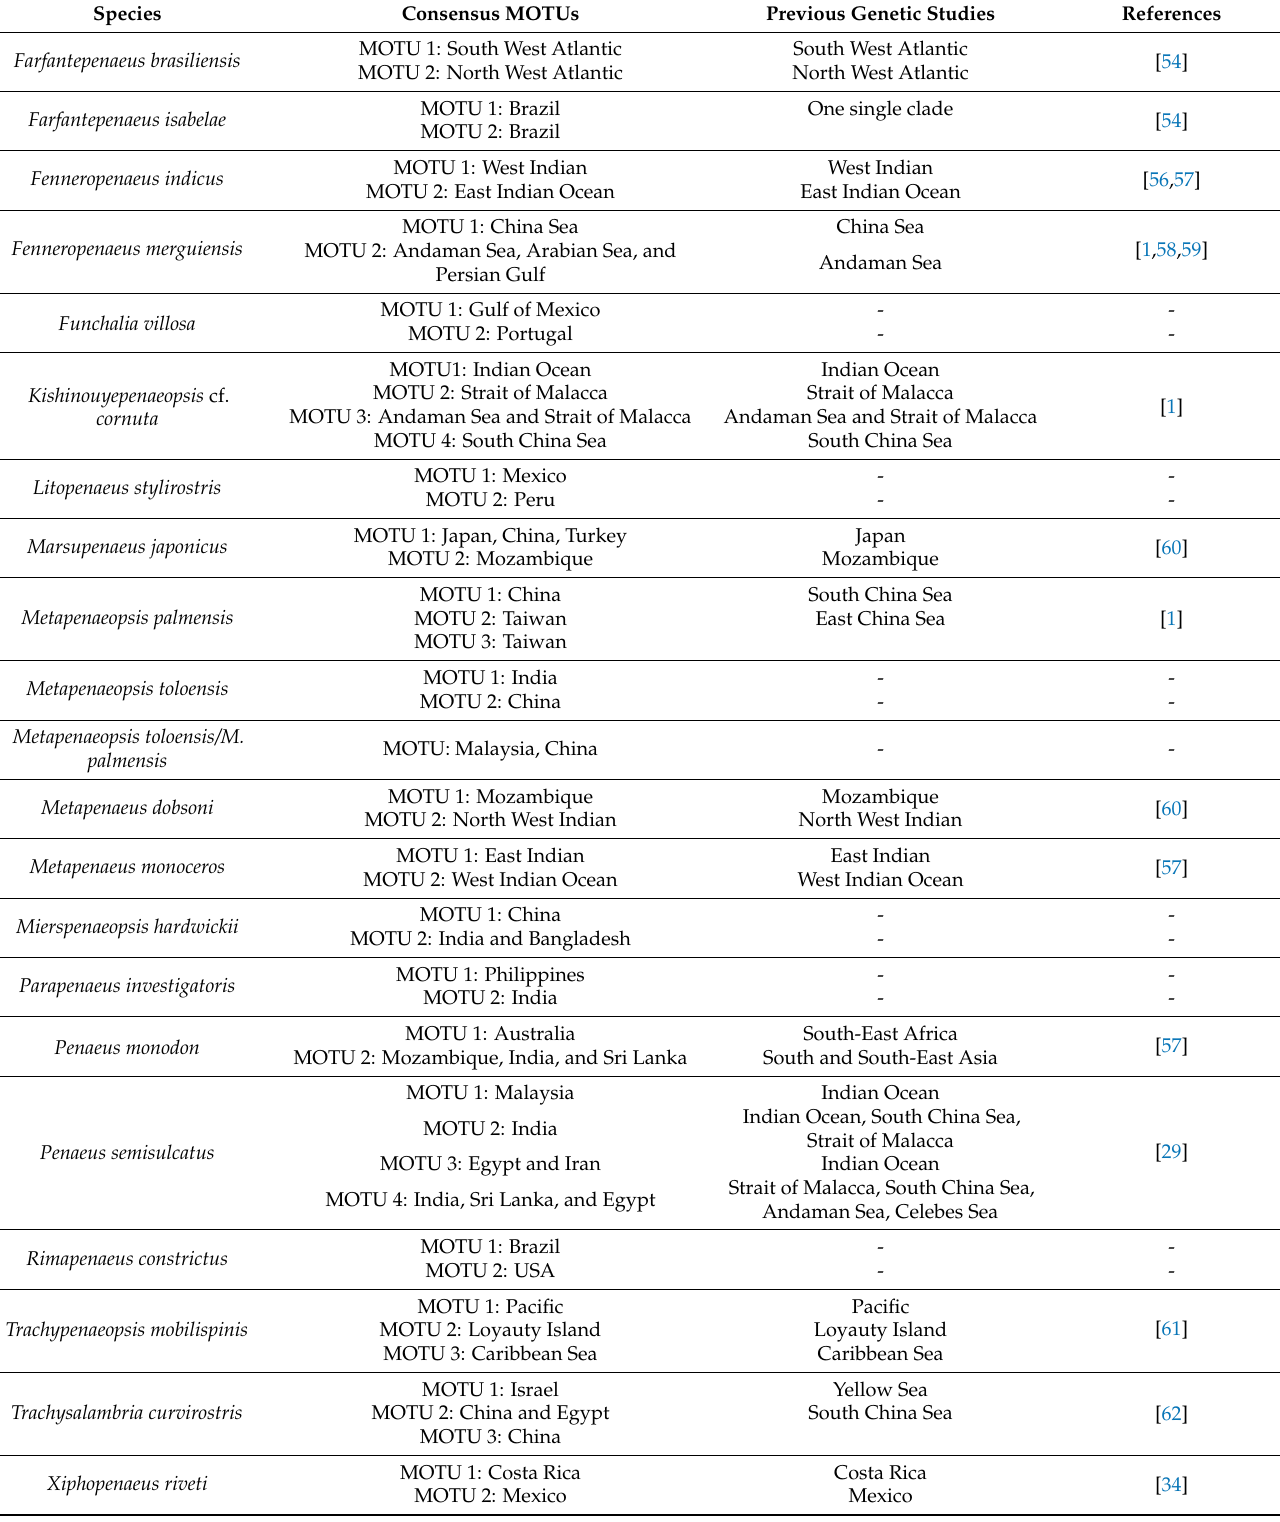
Table 1. Penaeid species exhibiting more of one